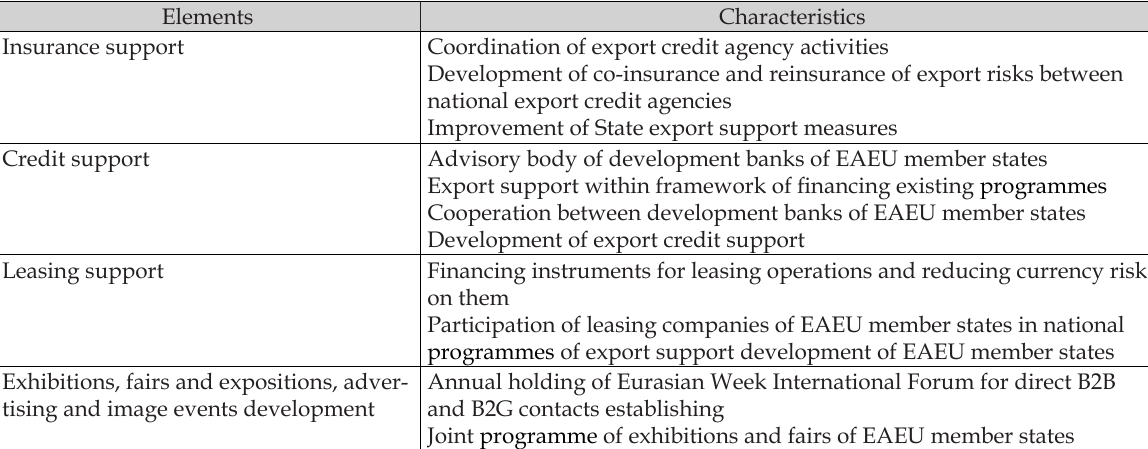
Table 6. EAEU export support system for cooperative products and services.